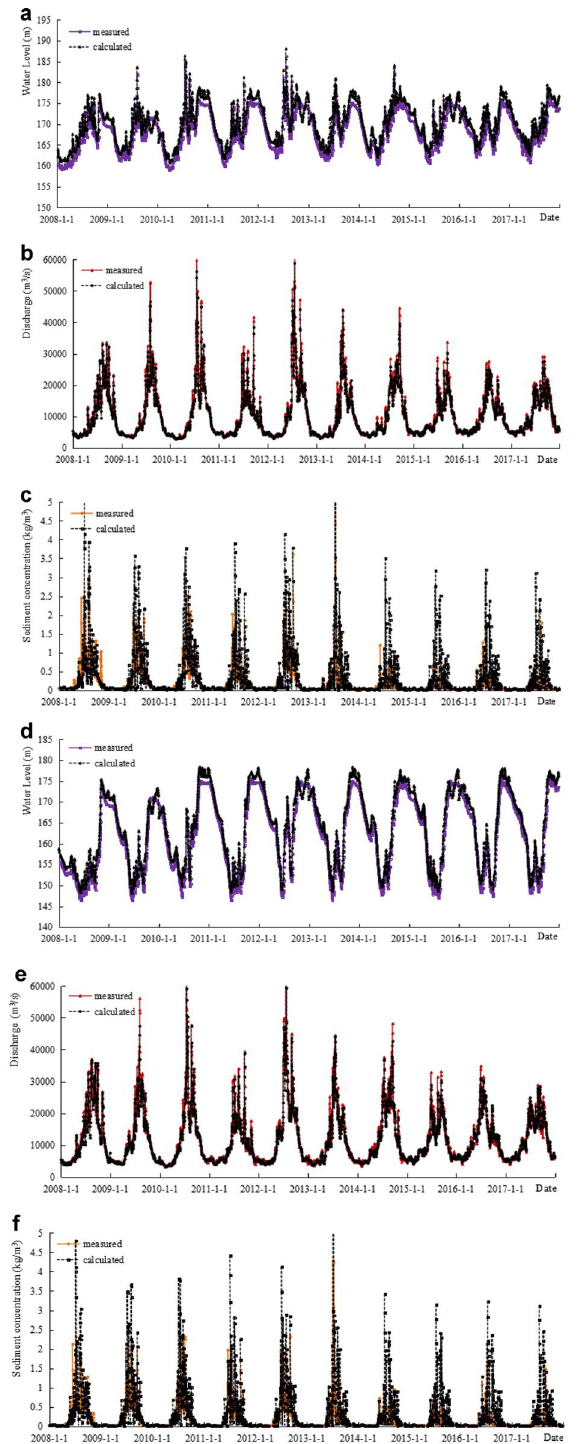
Figure 3. a Verification results of water level at Cuntan from 2008.1.1 to 2017.12.31. b Verification results of discharge at Cuntan from 2008.1.1 to 2017.12.31. c Verification results of sediment concentration at Cuntan from 2008.1.1 to 2017.12.31. d Verification results of water level at Qingxichang from 2008.1.1 to 2017.12.31. e Verification results of discharge at Qingxichang from 2008.1.1 to 2017.12.31. f Verification results of sediment concentration at Qingxichang from 2008.1.1 to 2017.12.31. g Verification results of water level at Wanxian from 2008.1.1 to 2017.12.31. h Verification results of discharge at Wanxian from 2008.1.1 to 2017.12.31. i Verification results of sediment concentration at Wanxian from 2008.1.1 to 2017.12.31. j Verification results of water level at Miaohe from 2008.1.1 to 2017.12.31. k Verification results of discharge at Miaohe from 2008.1.1 to 2017.12.31. l Verification results of sediment concentration at Miaohe from 2008.1.1 to